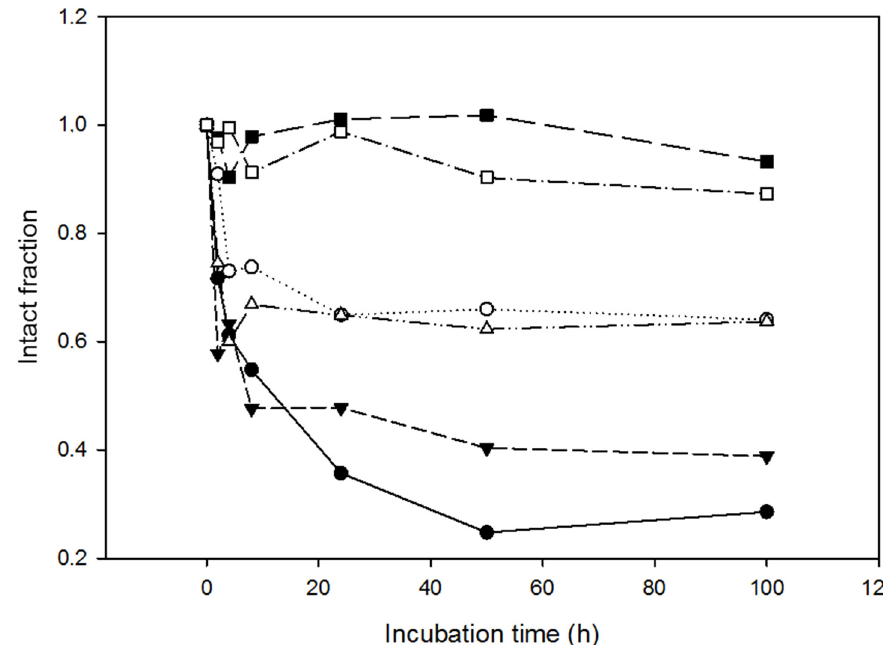
Figure 4. Resistance to proteolysis of the most stable ND-RNase variants when incubated in human sera. Amount of intact NLSPE5 (( for serum 1 and for serum 2); NLSPE5Cys1 ( ▼ for serum 1 and ∆ for serum 2); and NLSPE5Cys3 ( for serum 1 and for serum 2) along time when incubated in the presence of two different human sera at 37 °C.